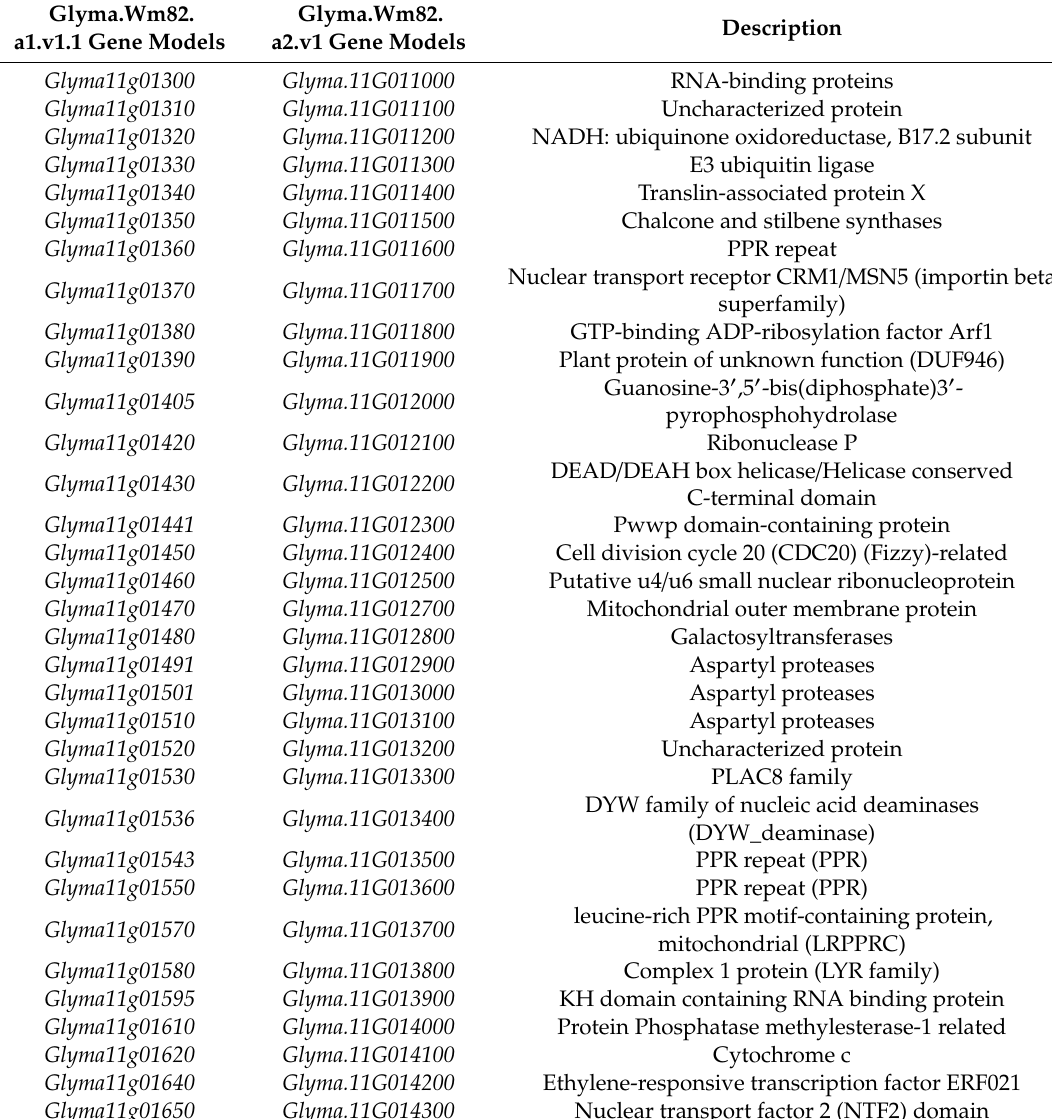
Table 3. List of gene models in the 263.3-Kb physical interval of the dsp2 locus. Glyma.Wm82.